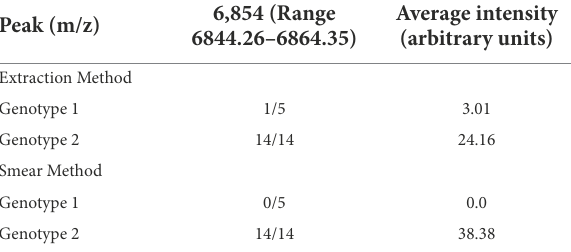
TABLE 3 The presence and intensity of peak 6,854 m/z used in the QC model for each of the validation group strains. Peak